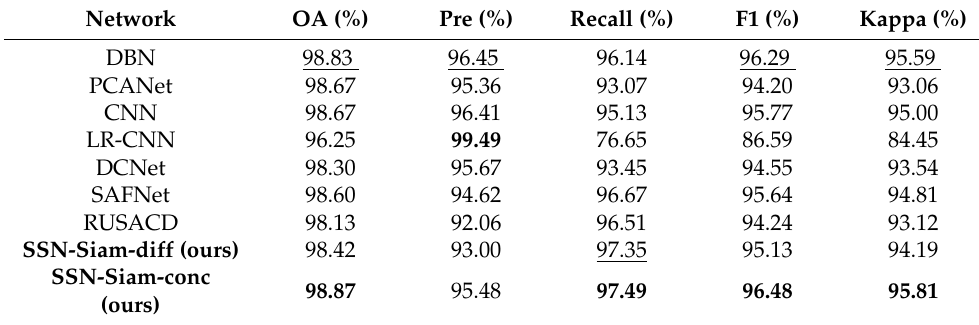
Table 8. Quantitative results of different methods used for the Ottawa dataset.